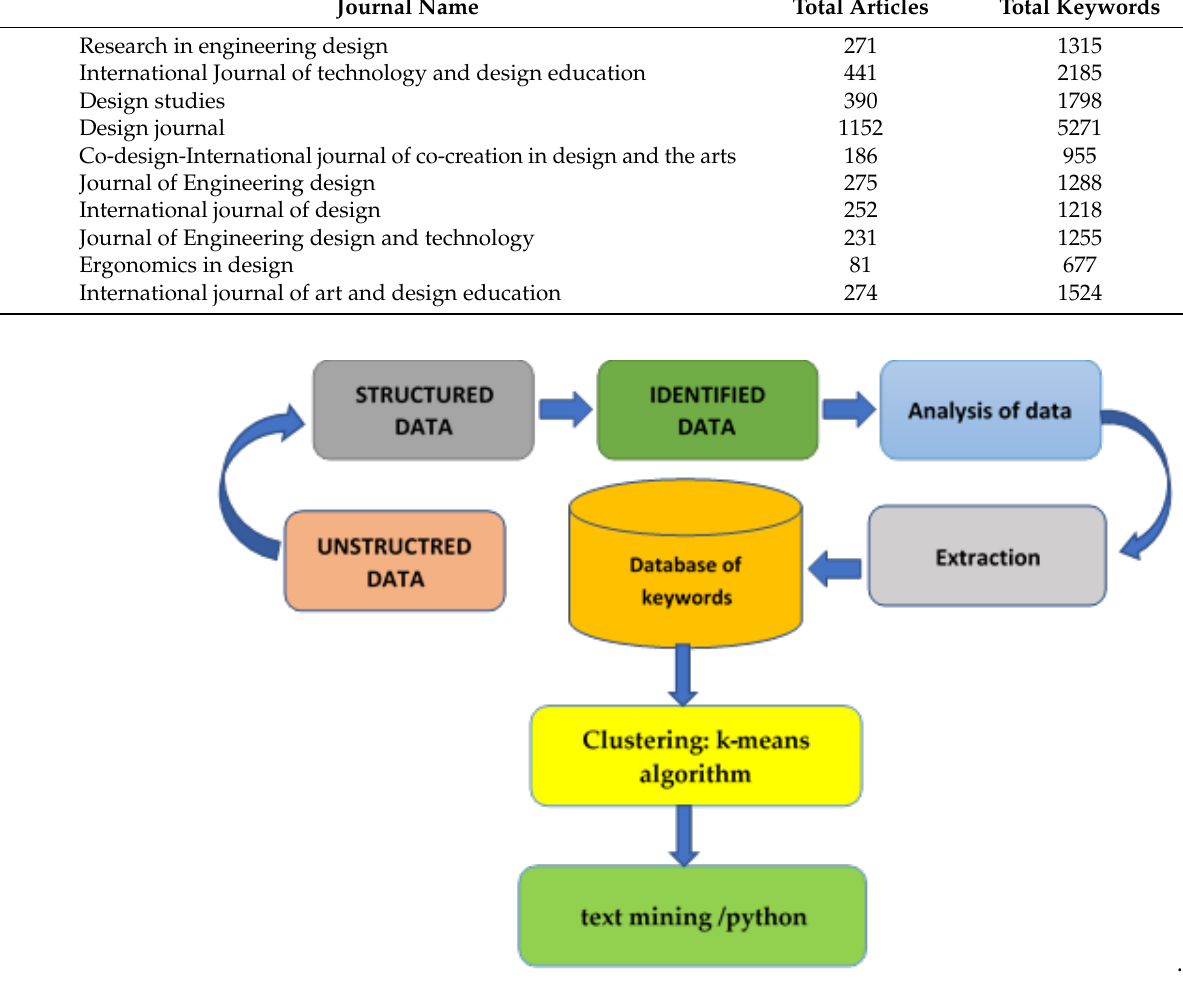
Figure 1. Research methodology used for the review of existing work. Table 1. Journal list and summary of articles and keywords ranged from 2007 – 2019 .